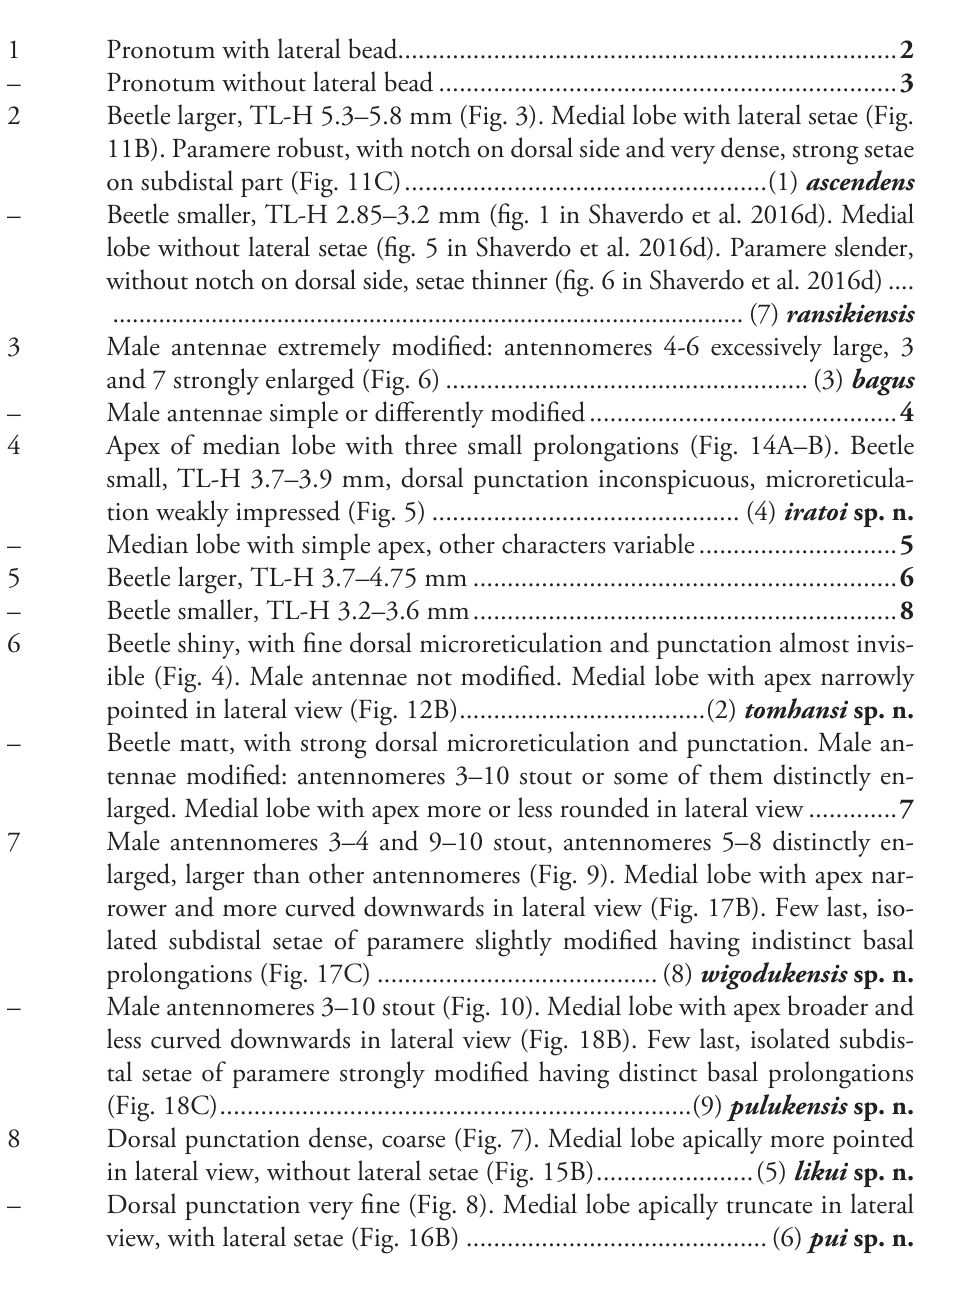
Beetle larger, TL-H 5.3–5.8 mm (Fig. 3). Medial lobe with lateral setae (Fig. 11B). Paramere robust, with notch on dorsal side and very dense, strong setae on subdistal part (Fig. 11C) .....................................................(1) ascendens – Beetle smaller, TL-H 2.85–3.2 mm (fig. 1 in Shaverdo et al. 2016d). Medial lobe without lateral setae (fig. 5 in Shaverdo et al. 2016d). Paramere slender, without notch on dorsal side, setae thinner (fig. 6 in Shaverdo et al. 2016d) .... ................................................................................................ (7) ransikiensis 3 Male antennae extremely modified: antennomeres 4-6 excessively large, 3 and 7 strongly enlarged (Fig. 6) ..................................................... (3) bagus – Male antennae simple or differently modified ............................................. 4 4 Apex of median lobe with three small prolongations (Fig. 14A–B). Beetle small, TL-H 3.7 –3.9 mm, dorsal punctation inconspicuous, microreticula- tion weakly impressed (Fig. 5) ............................................. (4) iratoi sp. n. – Median lobe with simple apex, other characters variable ............................. 5 5 Beetle larger, TL-H 3.7–4.75 mm .............................................................. 6 – Beetle smaller, TL-H 3.2–3.6 mm .............................................................. 8 6 Beetle shiny, with fine dorsal microreticulation and punctation almost invis- ible (Fig. 4). Male antennae not modified. Medial lobe with apex narrowly pointed in lateral view (Fig. 12B) ....................................(2) tomhansi sp. n. – Beetle matt, with strong dorsal microreticulation and punctation. Male an- tennae modified: antennomeres 3–10 stout or some of them distinctly en- larged. Medial lobe with apex more or less rounded in lateral view ............. 7 7 Male antennomeres 3–4 and 9–10 stout, antennomeres 5–8 distinctly en- larged, larger than other antennomeres (Fig. 9). Medial lobe with apex nar- rower and more curved downwards in lateral view (Fig. 17B). Few last, iso- lated subdistal setae of paramere slightly modified having indistinct basal prolongations (Fig. 17C) ......................................... (8) wigodukensis sp. n. – Male antennomeres 3–10 stout (Fig. 10). Medial lobe with apex broader and less curved downwards in lateral view (Fig. 18B). Few last, isolated subdis- tal setae of paramere strongly modified having distinct basal prolongations (Fig. 18C) .....................................................................(9) pulukensis sp. n. 8 Dorsal punctation dense, coarse (Fig. 7). Medial lobe apically more pointed in lateral view, without lateral setae (Fig. 15B) .......................(5) likui sp. n. – Dorsal punctation very fine (Fig. 8). Medial lobe apically truncate in lateral view, with lateral setae (Fig. 16B) ............................................ (6) pui sp.